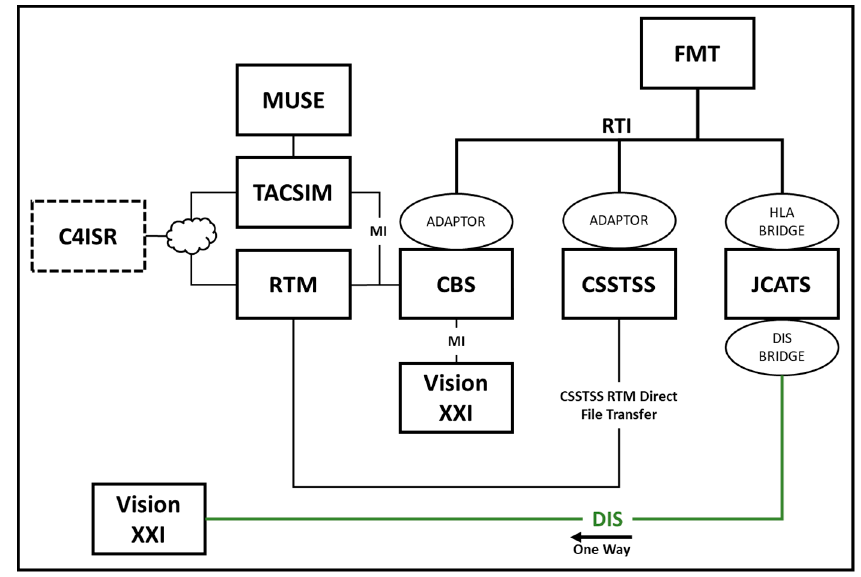
Figure 16. ACTF-MRM architecture (adapted from [46]).